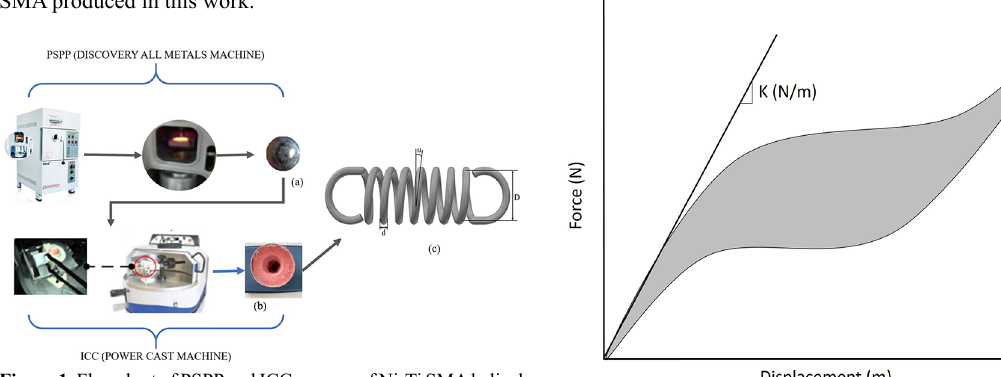
Figure 1 . Flowchart of PSPP and ICC process of Ni-Ti SMA helical spring: (a) Ni-Ti SMA bulk, (b) Ceramic mould, (c) Ni-Ti SMA extension spring.